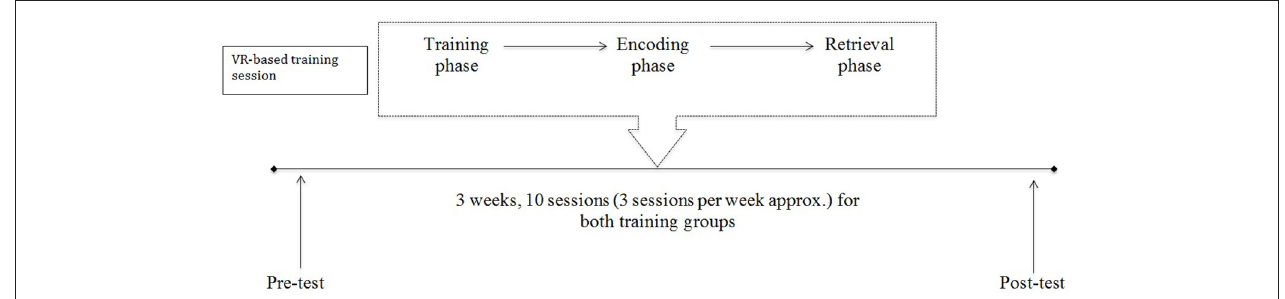
FIGURE 1 | Timeline of the VR-based training program. The training consisted of 10 sessions for 3–4 consecutive weeks, with approximately three sessions a week. After brief training in VR technology (about 2 min), each session comprised two parts: an “ encoding ” and a “ retrieval phase. ” Participants were assessed with a comprehensive neuropsychological assessment before and after participation in the training.